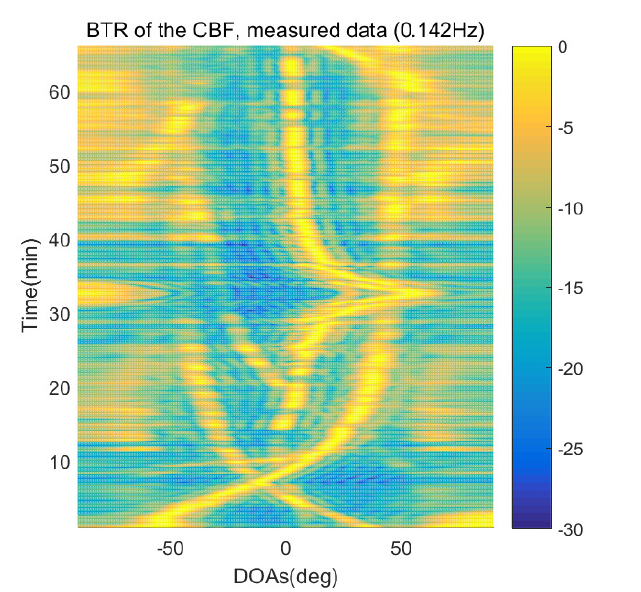
Figure 18. Bearing time records of the CBF: 66 min, signal frequency = 0.142 Hz.